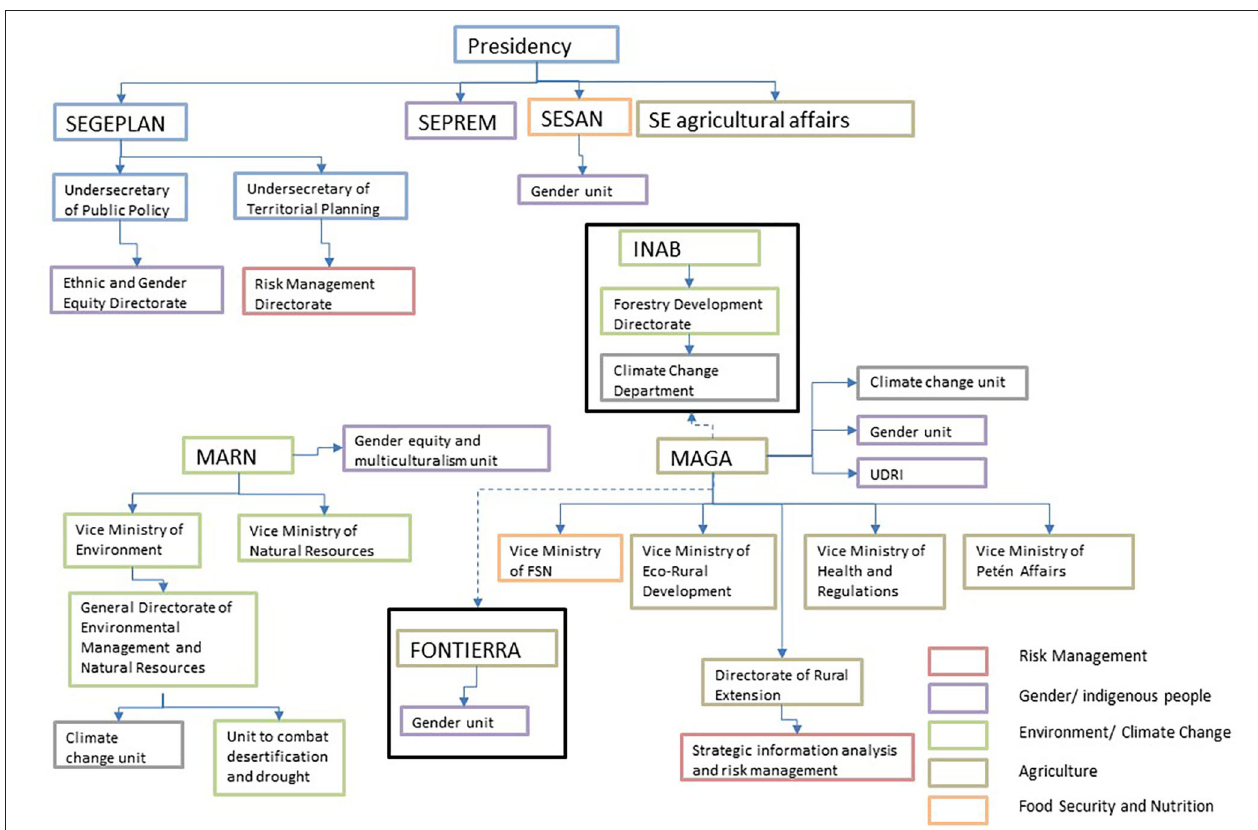
FIGURE 1 | Guatemalan government infrastructure on gender, agriculture, climate change, environment, risk management, and food security and nutrition (own elaboration).